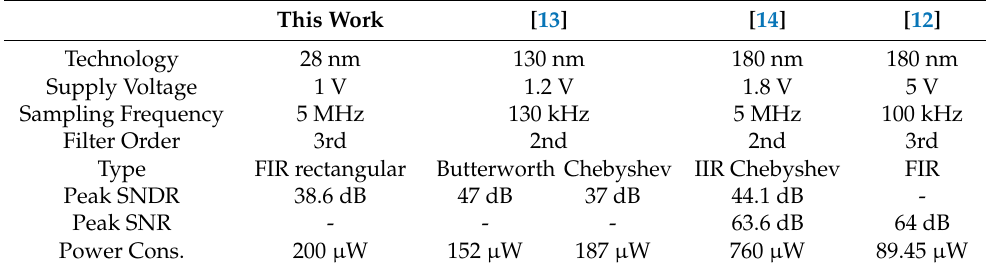
Table 2. Performance comparison with the state-of-the-art time-mode low-pass